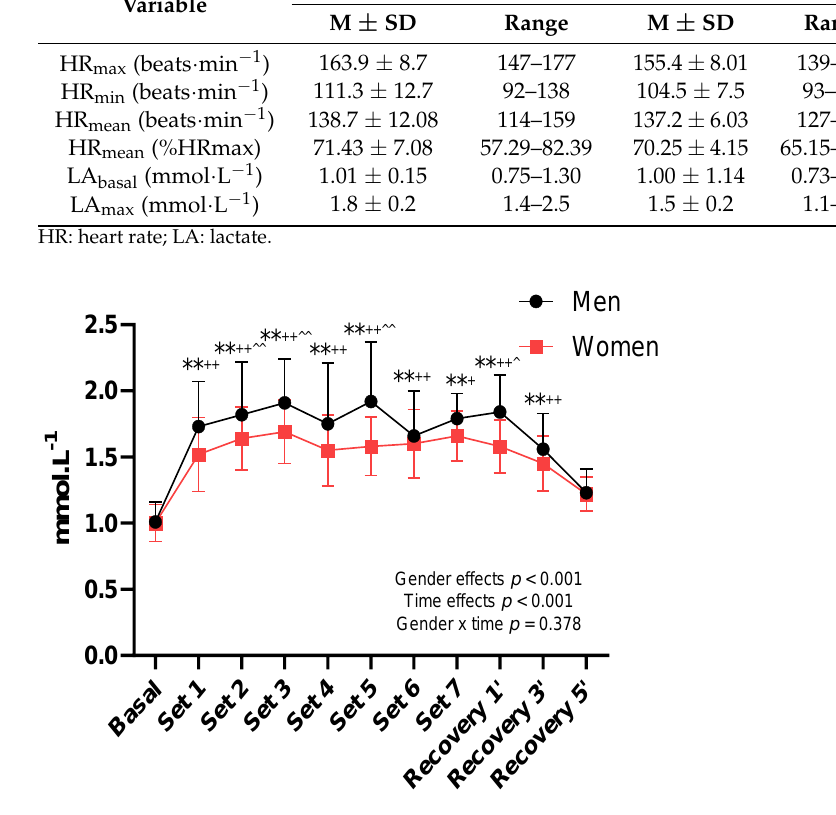
Figure 3. LA evolution during SC in men and women; ** p < 0.01 Basal vs. other measurements; + p < 0.05 Recovery 5′ vs. other measurements; ++ p < 0.01 Recovery 5′ vs. other measurements; ^ p < 0.05 Recovery 3′ vs. other measurements; ^^ p < 0.01 Recovery 3′ vs. other measurements.